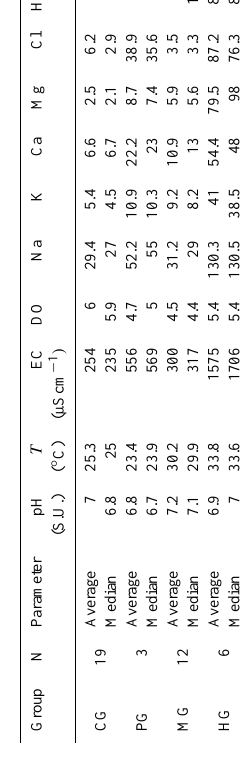
Figure 4. Dendrogram showing HCA classification with groups and subgroups of samples of the Atemajac–Toluquilla aquifer system. The dashed line indicates the “phenon line”, an arbitrary line that defines subgroups.